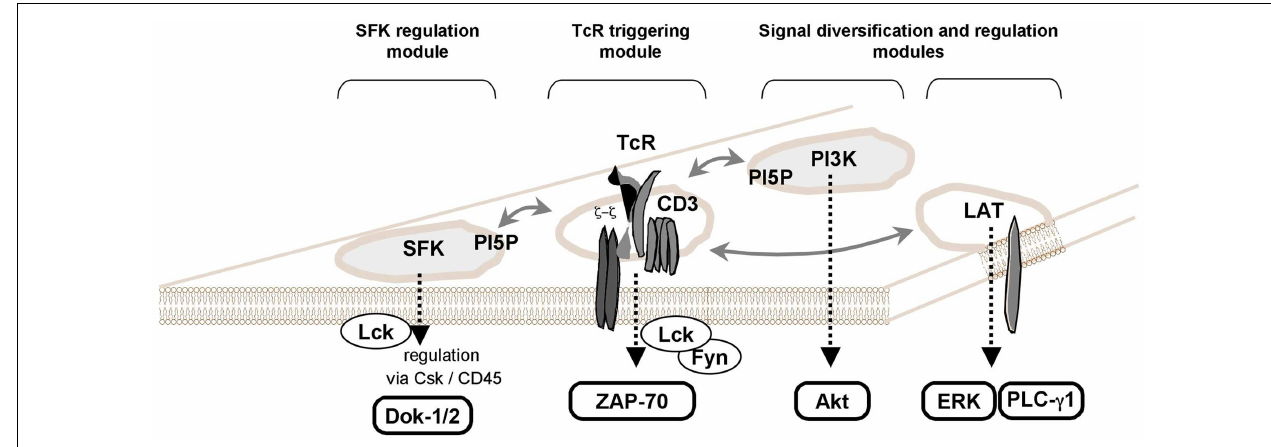
be involved in establishing fullTCR signals, when there are interconnected. In this scheme, we added a separated module for PI3K/Akt signaling where the Class IA PI3K could recognize a SFK or some membrane protein containing aTyr-x-x-Met motif. Plasma membrane PI5P could participate to the lipid compounds of some of these modules such as SFK regulation module and PI3K-dependent signal diversification/regulation module (see